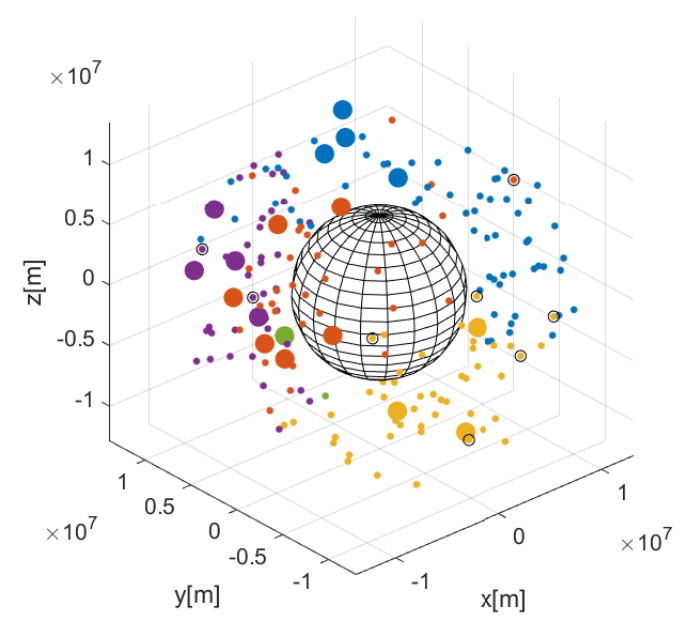
Figure 6. Task-planning result for 20 satellites and 200 objects with 5 and 12 clusters, respectively. Big filled circles, satellites; small filled dots, objects; black circles, objects allocated to multiple satellites.